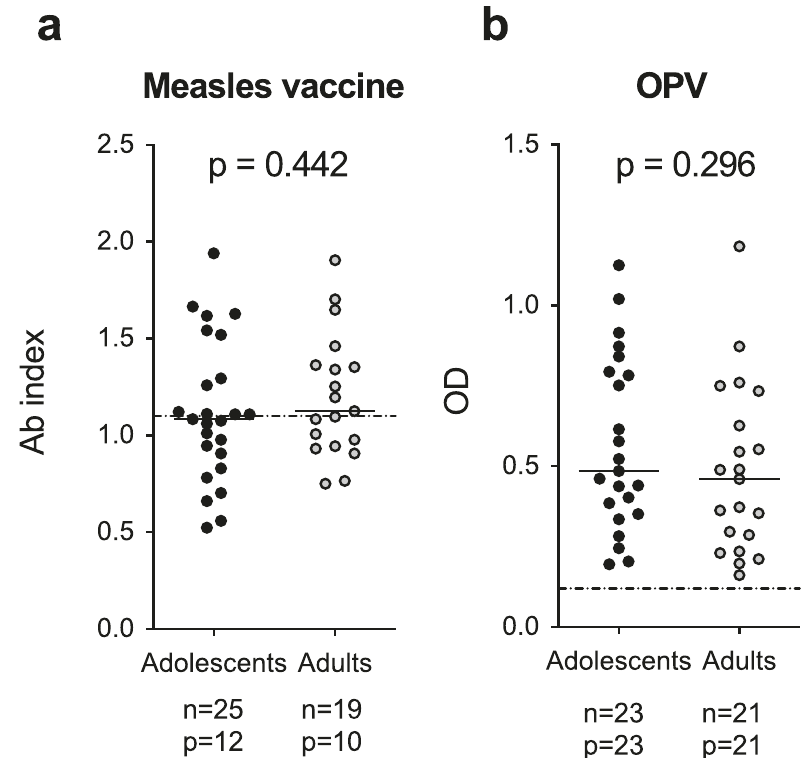
Fig. 6 Humoral immune responses toward childhood vaccines. a , b The presence of antibodies toward the measles ( a ) and oral polio (OPV, b vaccines were measured in subjects and presented as antibody index or optical density (OD), according to the assay used. Dotted lines represent cut-off values for positivity. The number of subjects analyzed (n) and of positive individuals (p) for each age-group are reported in the fi gure. Statistical signi fi cance was determined by the Mann-Whitney test and all p -values are